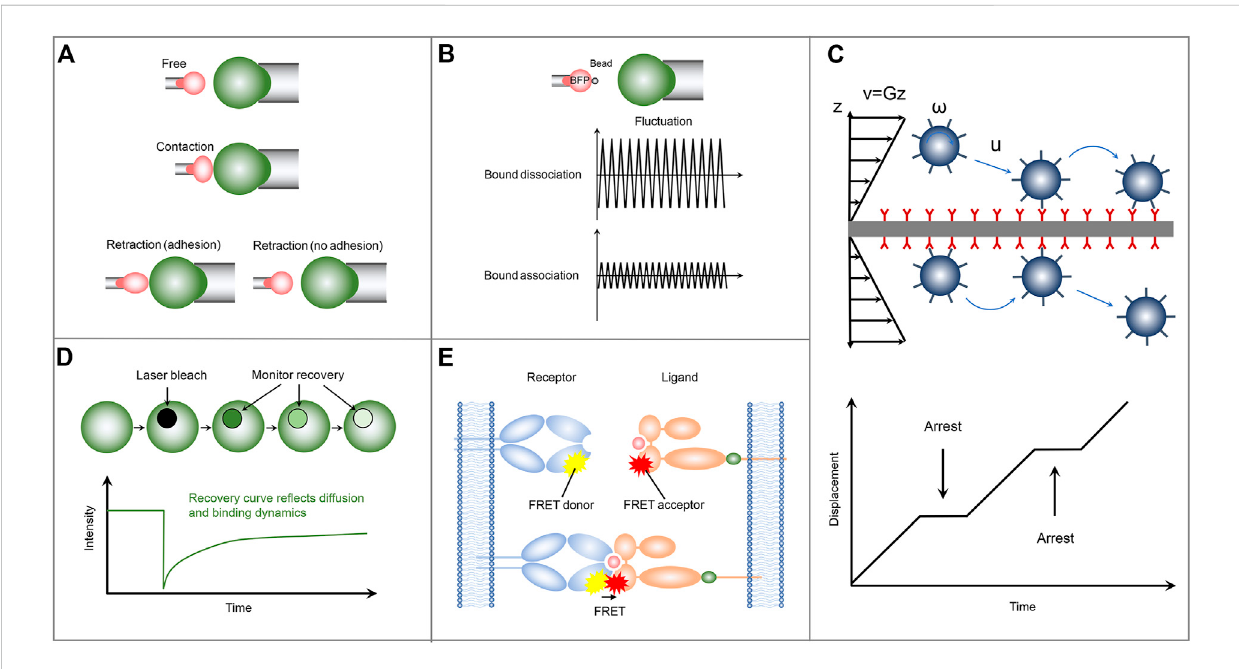
FIGURE 2 Schematicsoftherepresentativemechanical-basedand fl